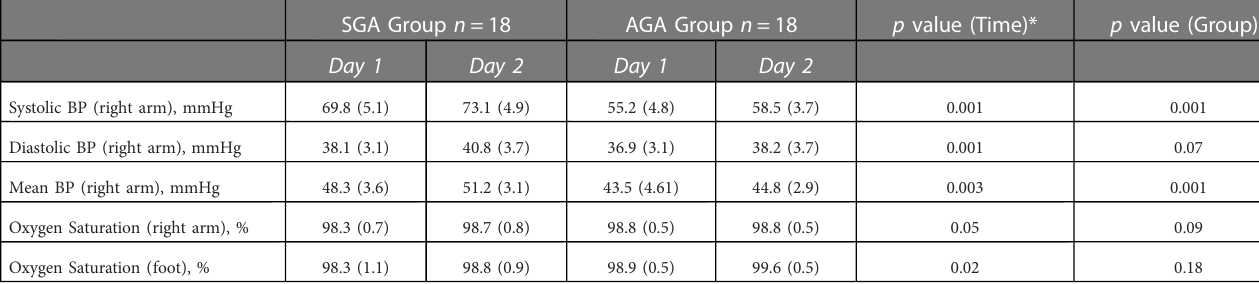
TABLE 2 Effects of group and time on preductal blood pressure and pre- and postductal oxygen